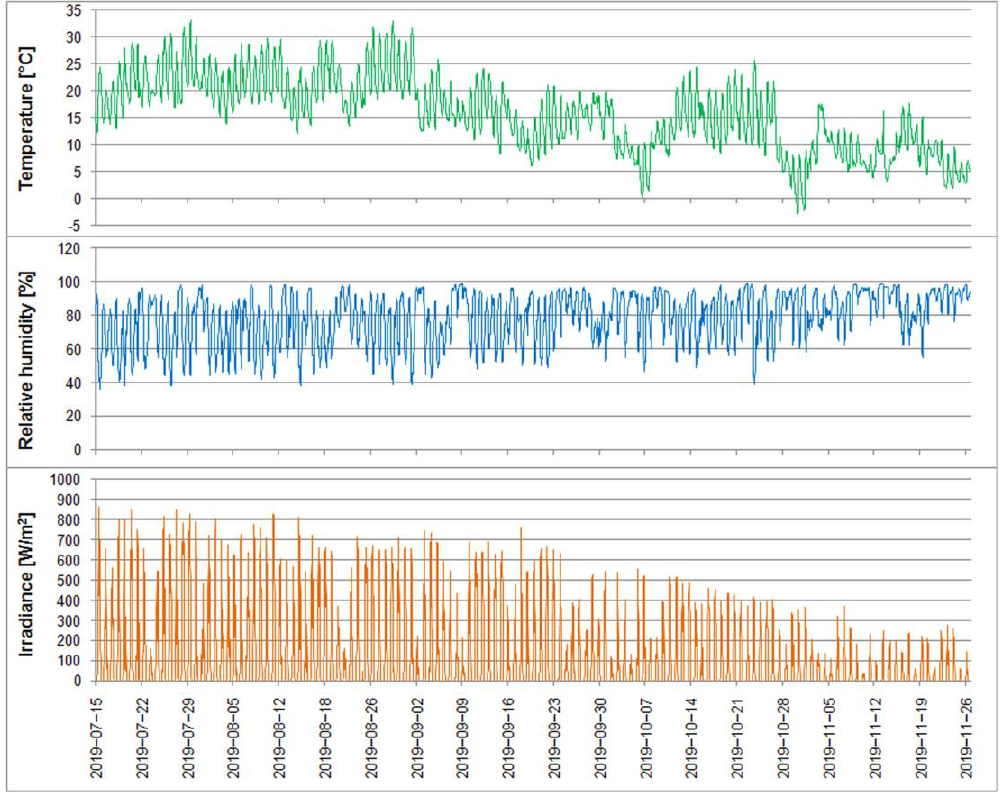
Figure 5. External air temperature, relative humidity and global horizontal irradiance during the measurement